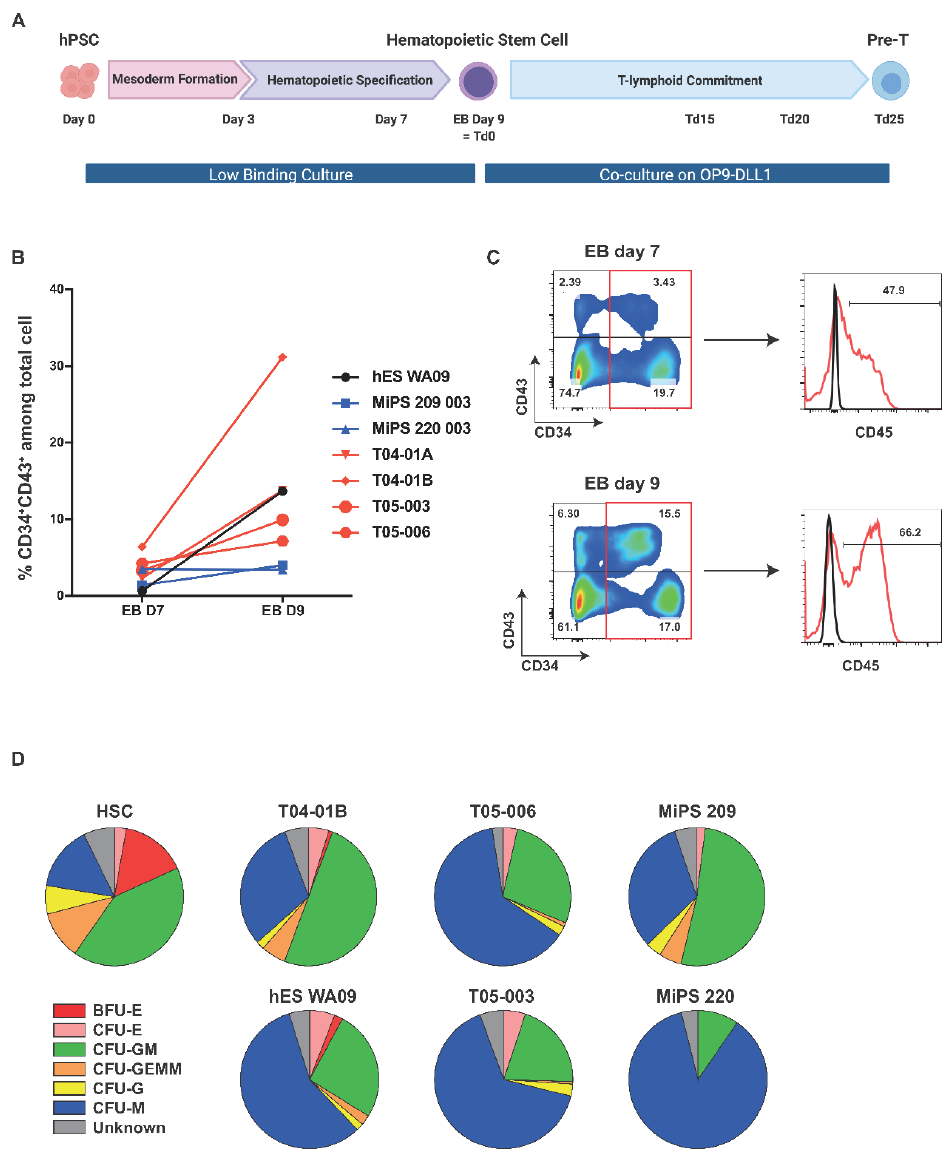
Figure 2. Multipotent HPSCs were derived from hPSCs. ( A ) Schematic representation of the hematopoietic stem cell differentiation protocol. Between day 0 and day 9, EBs were treated to induce firstly mesoderm formation and then to induce specification towards the hematopoietic lineage. After 9 days, the EBs were dissociated and the cells were co-cultured on OP9-DLL1 or DLL4 cells in a specific medium to induce T-lymphoid commitment. ( B ) Evolution of the percentage of total cells expressing CD34 and CD43 between day 7 and day 9 and expression of CD45. ( C ) Flow cytometry analysis of differentiating cells at D7 and D9 in EB culture from hPSC. Representative dot plots of CD34 and CD43 co-staining on living cells are shown. The expressions of CD45 in CD34 + cells are shown. Red line represents cells stained with a fluorescent antibody and black line represents unstained cells. ( D ) Analysis of visual microscopic counting of CFU assay blood colonies for the indicated cell lines. Data are presented as a pool of experimental duplicates, n = 1.